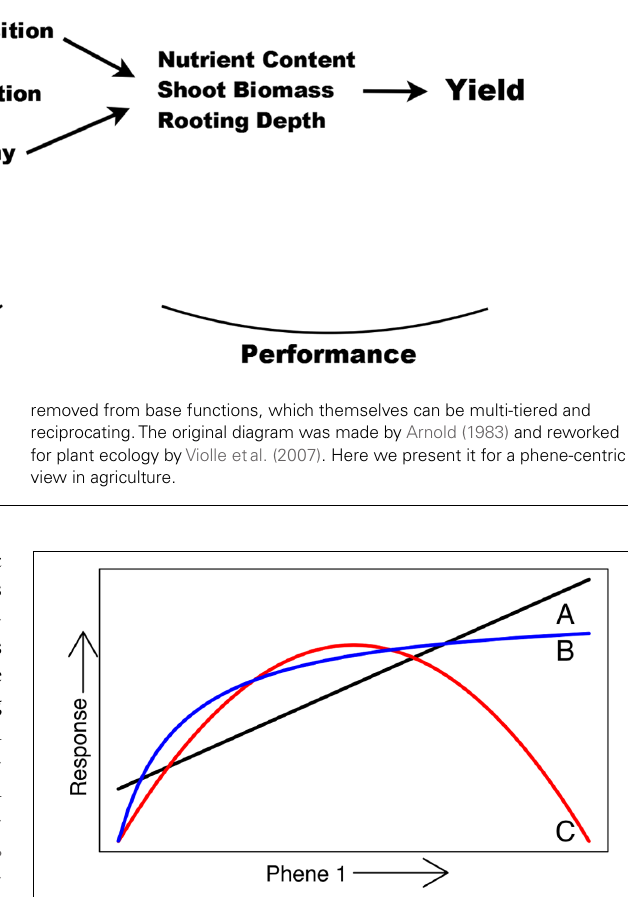
FIGURE 3 |A phene-function response curve shows the influence of a single continually varying phene on a plant functional response. A phene may have a linear effect on the response (A) , asymptote (B) , or have an optimum at middle states (C)